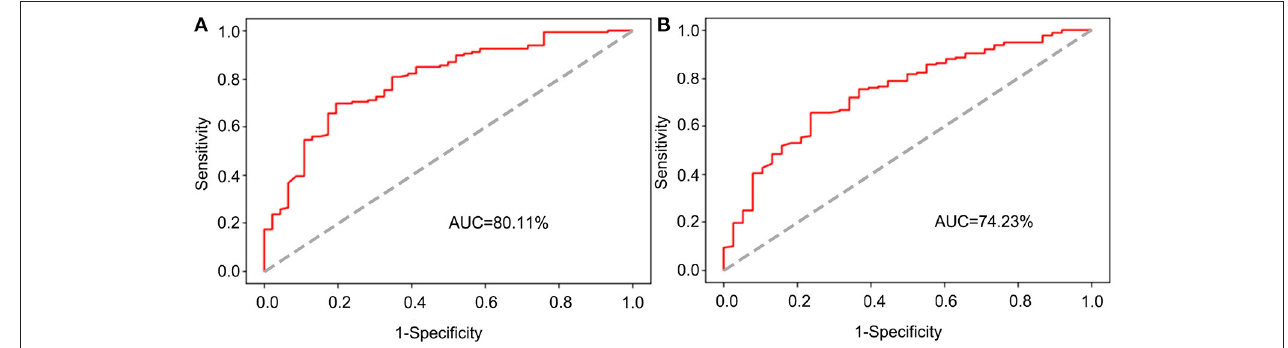
FIGURE 5 | The receiver operating characteristic (ROC) curve for validation of the BN and nomogram model based on the testing dataset. (A) The ROC curve for validation of the BN model. (B) The ROC curve for validation of the nomogram.